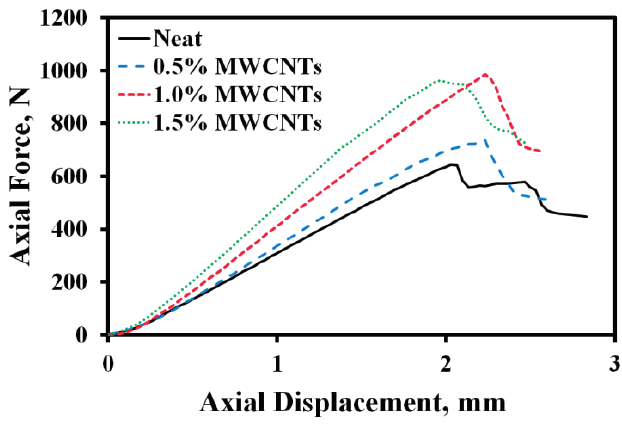
Figure 16. A depiction of the flexural test